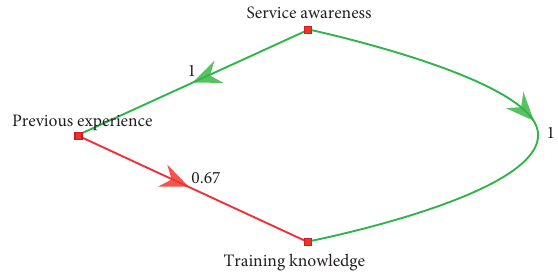
Figure 4: Credal ranking for the “Knowledge” dimension.